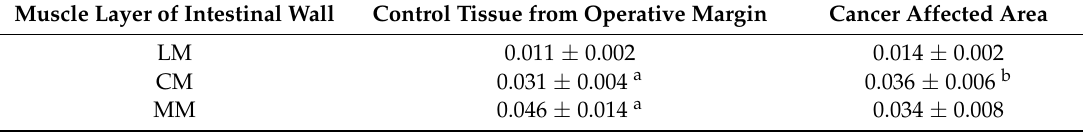
Table 2. The number of CART-LI nerve fibers in the longitudinal muscle layer (LM), circular muscle layer (CM) and lamina muscularis mucosa (MM) in control and cancer-affected areas of the human colonic wall. Muscle Layer of Intestinal Wall Control Tissue from Operative Margin Cancer Affected Area